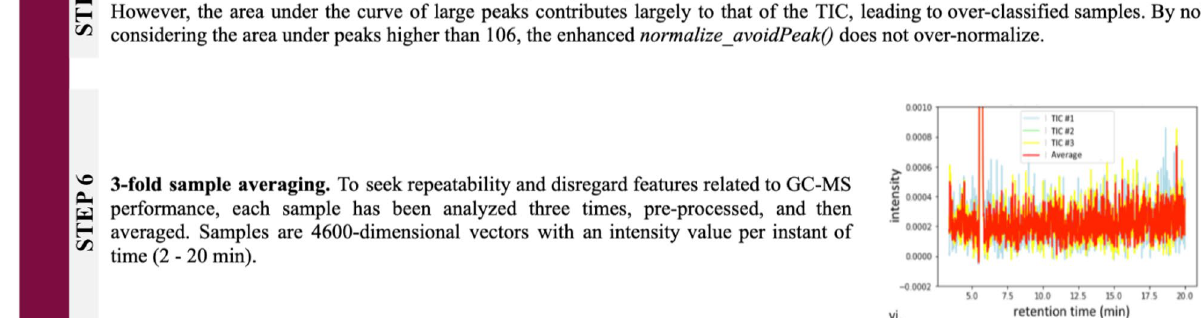
Figure 3. Summary of the pre-processing steps from GC–MS raw data reading up to total ion chromatogram (TIC) design. Sample 151 (belonging to a breast cancer subject) has been used to illustrate those